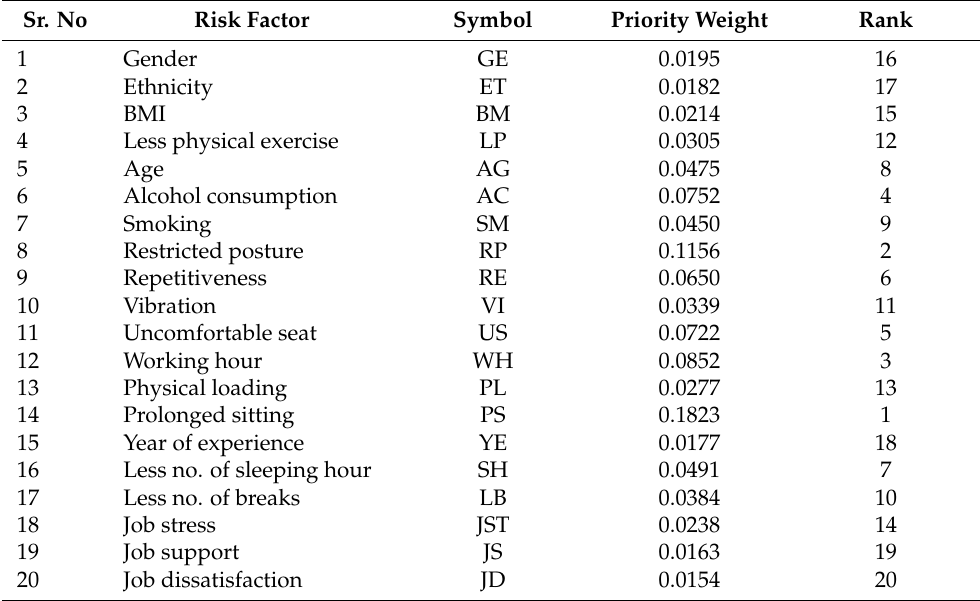
Table 9. Priority weight and ranking of criteria/risk factors.